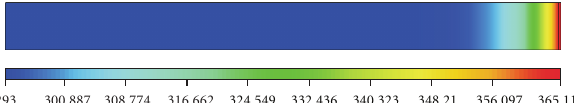
Figure 5: Temperature pattern (K) through the thickness of the inner containment wall at the time 10,000 s after the beginning of accidental steam-hydrogen mixture release.